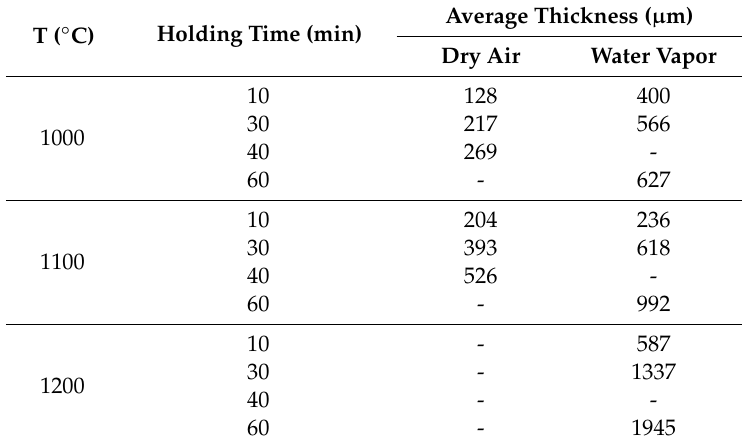
Table 1. Thickness of oxide scales formed under dry air and water vapor